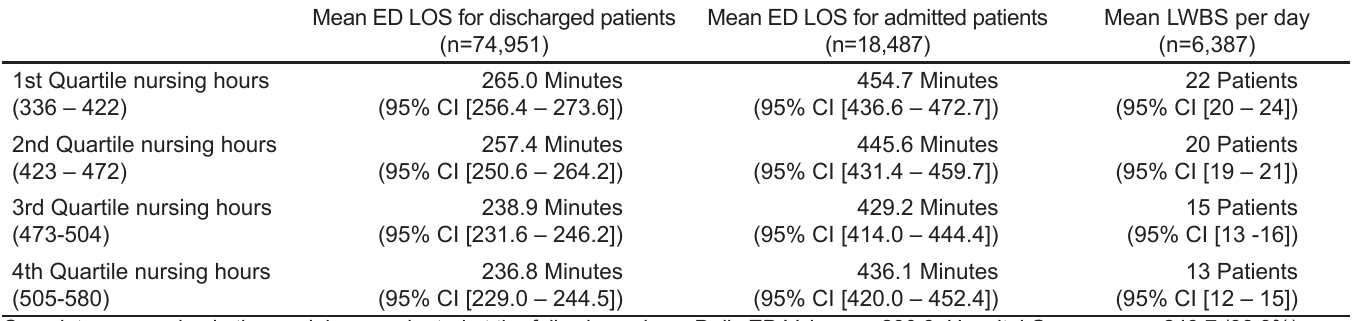
Table. Outcome variables.